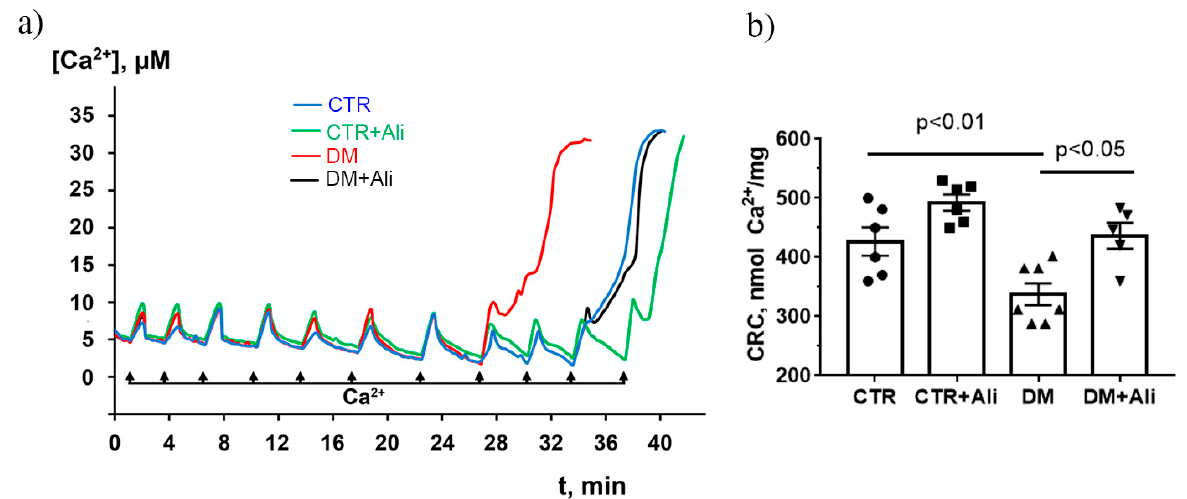
Figure 6. Changes in the external (Ca 2+ ) upon the successive addition of Ca 2+ pulses (10 µ M) to the suspension of the skeletal muscle mitochondria of the experimental animals ( a ). Ca 2+ retention capacity of skeletal muscle mitochondria of experimental animals ( b ). The values are given as means ± SEM ( n = 6).